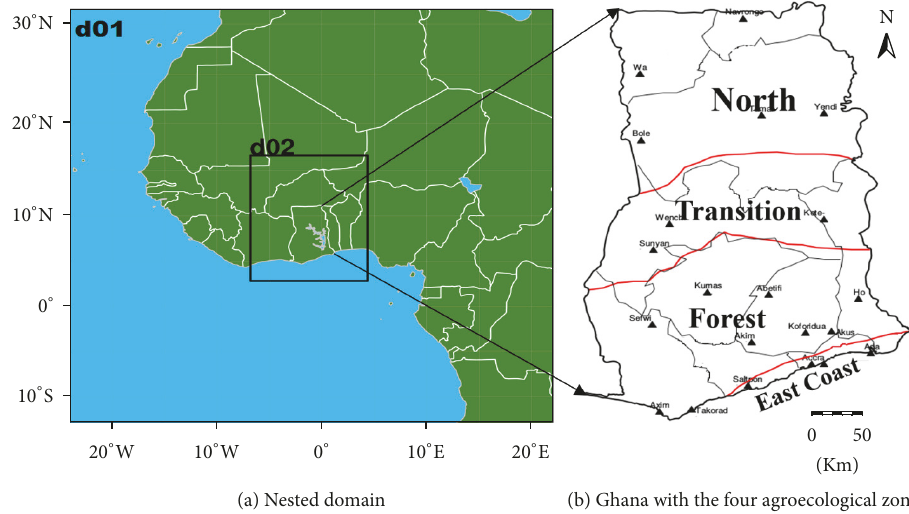
Figure 2: (a) Nested domain, inner domain (d02), at 10km resolution and the outer domain (d01) at 50 km resolution with (b) the study area, Ghana, projected out with the four agroecological zones (adopted from Ghana Meteorological